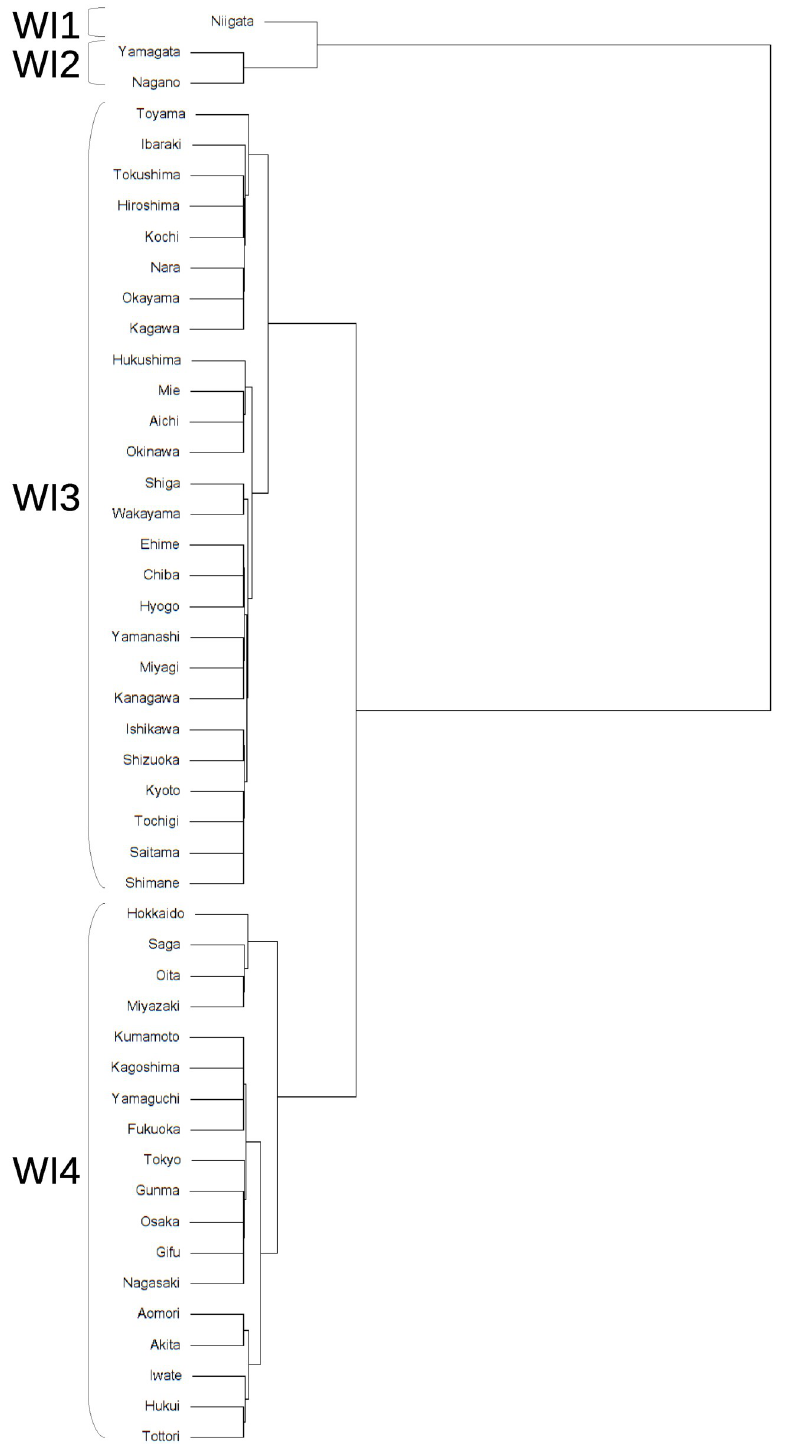
Fig 16. A dendrogram for seasonal indices in inbound guests for tourism.